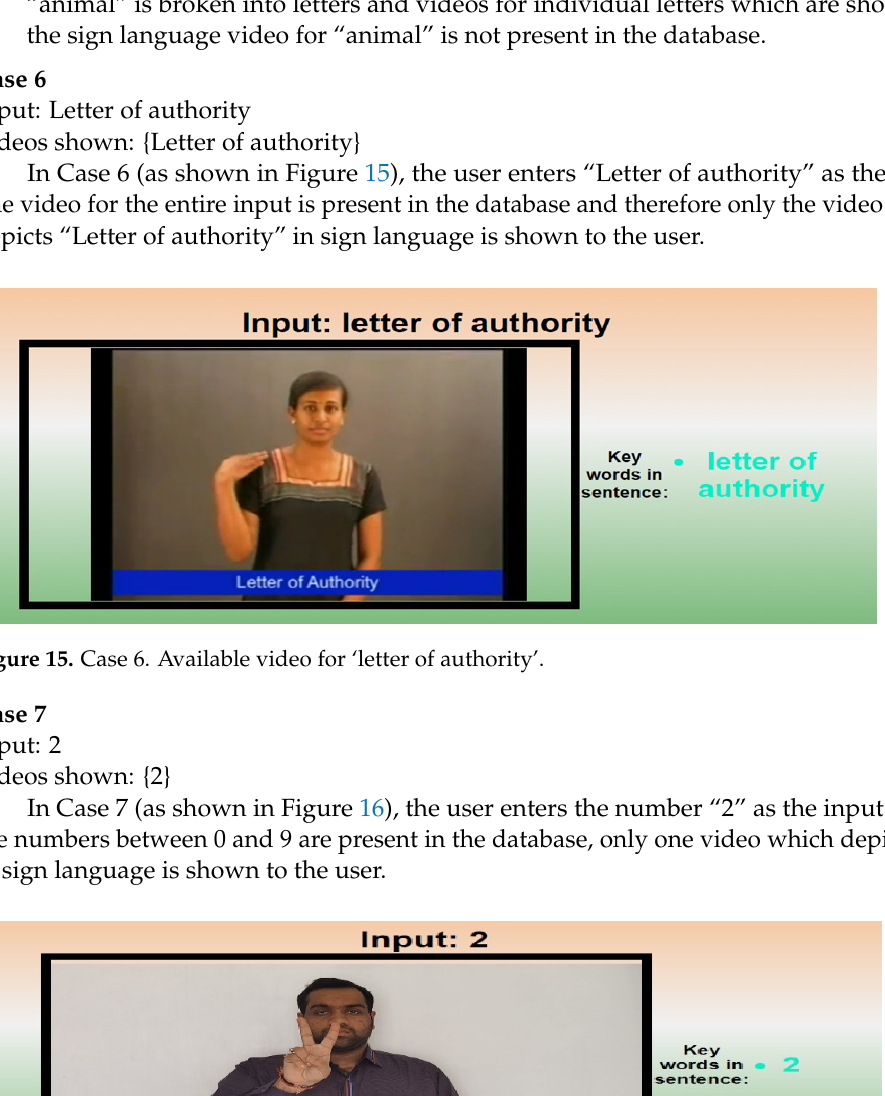
Figure 16. Case 7. Available video for number ‘2’.